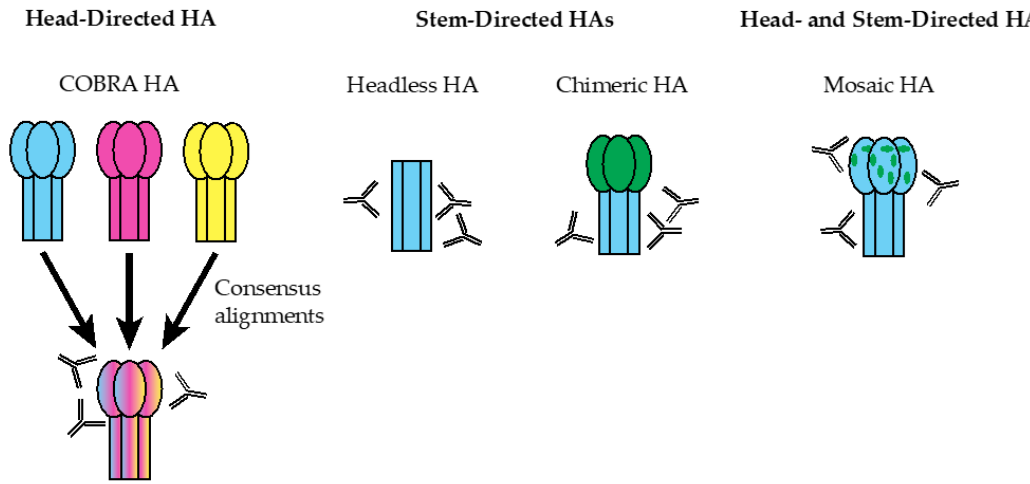
Figure 2. HA-based universal influenza vaccine designs. COBRA (computationally optimized broadly reactive antigen)- based HAs are head-focused HA immunogens incorporating multiple HA sequences of distinct virus strains (shown as HAs of different colors) of a particular subtype into a consensus COBRA HA (shown as a merged HA of multiple colors) that elicit mainly head-targeting antibodies. Headless HAs lack the globular head domain and are comprised solely of the stem domain to focus antibody responses to the otherwise immunosubdominant, but conserved, stem. Chimeric HAs (cHAs) consist of the globular head domain of one subtype (shown in green) and the stem domain of another subtype (shown in cyan) to be targeted, more closely mimicking a native HA molecule while focusing antibody responses to the conserved stem through exposure to multiple cHA immunogens. Mosaic HAs (mHAs), which can be seen as a refinement of cHAs, consist of the majority of the head domain and the entire stem domain of one subtype (shown as a blue HA trimer), but the head antigenic sites of another subtype (shown as green regions in the HA head), eliciting both head- and stem-directed antibodies.